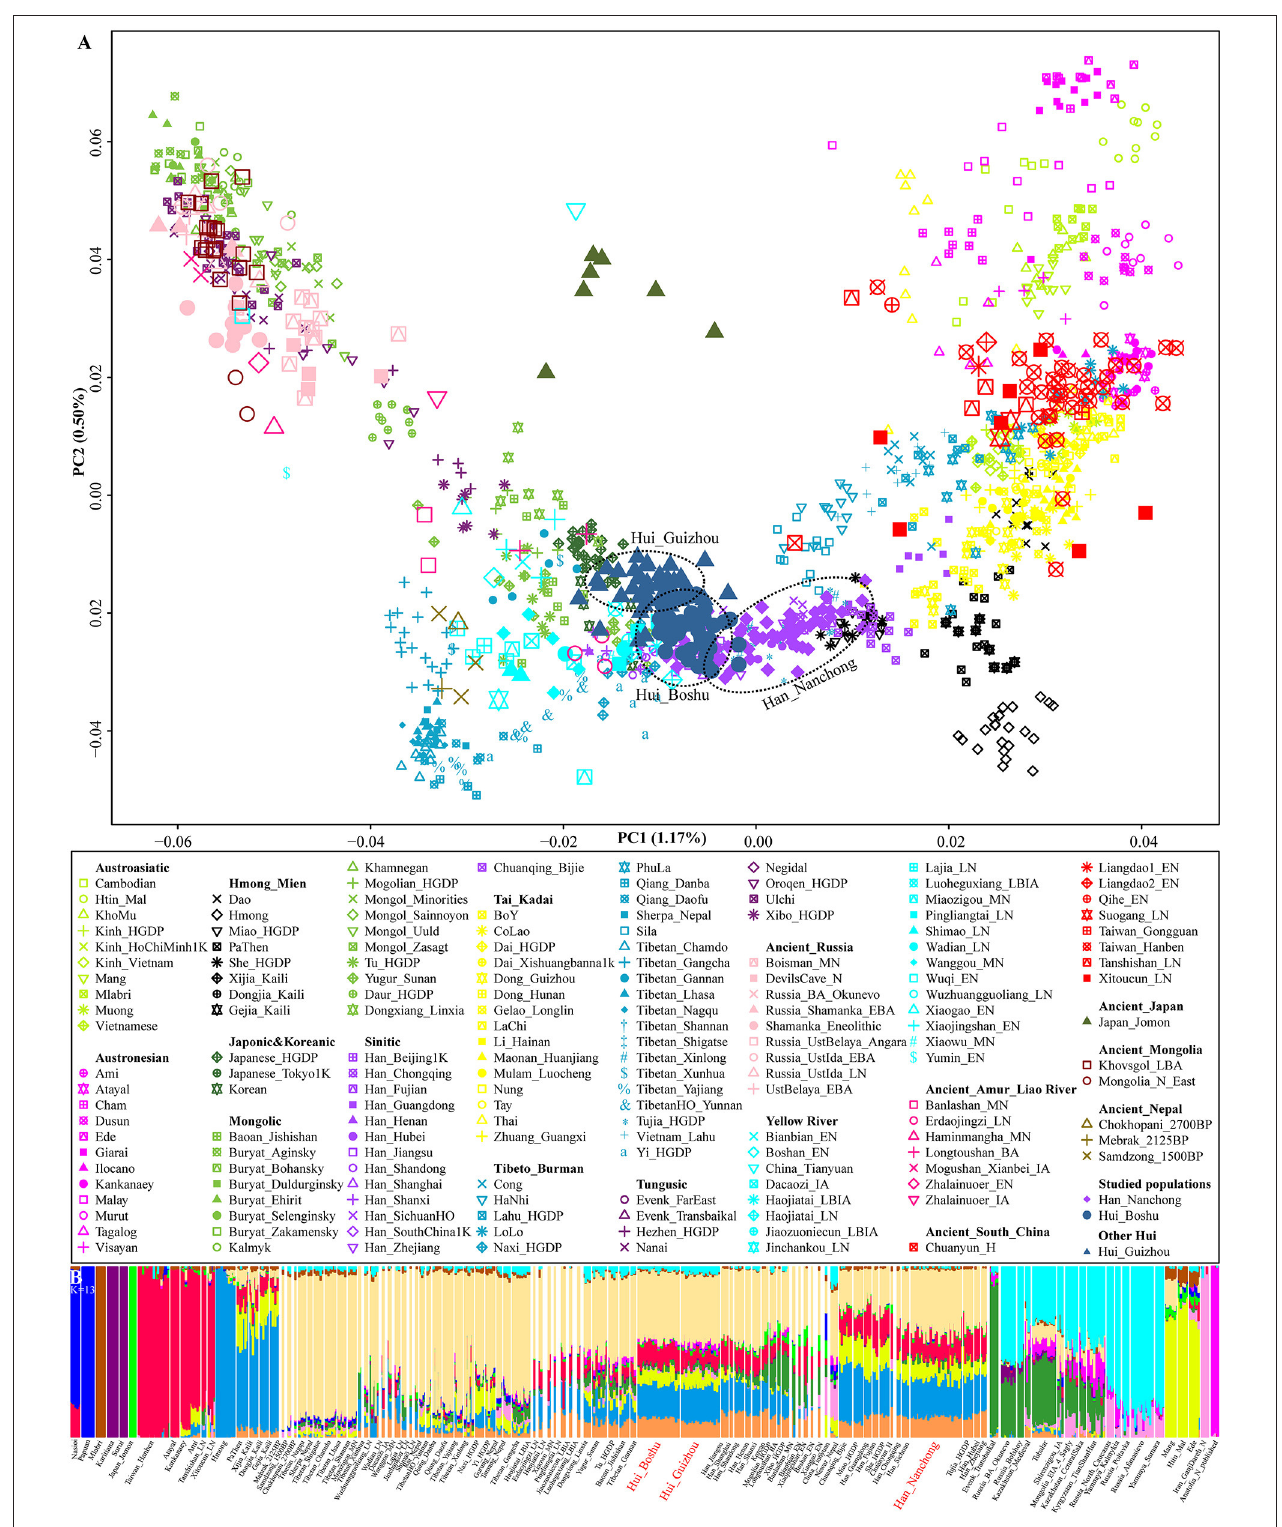
FIGURE 1 | Overview of population structure. (A) Principal component analysis (PCA) based on the top two components of East Asian genetic variations. Included ancient individuals were projected onto the modern genetic background. (B) Ancestry component composition between Boshu Hui, Nanchong Han, and other Eurasian reference populations when the optimal K value is equal to